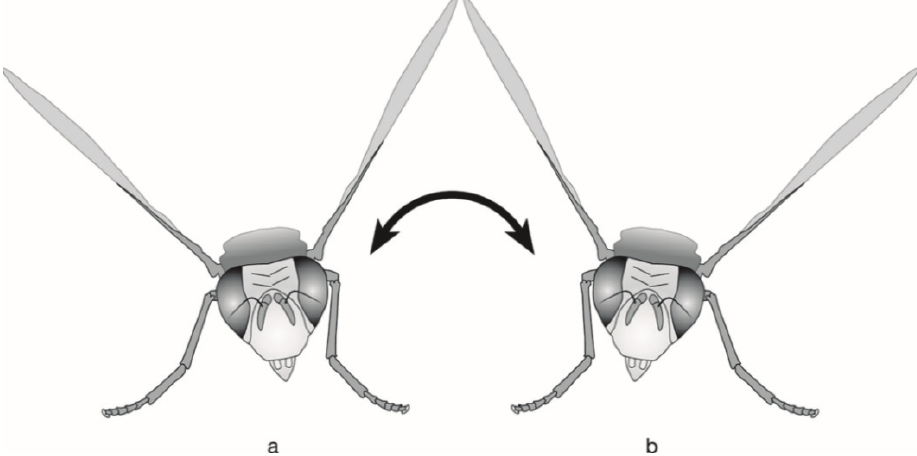
Figure 7. Illustration of the lofting/body swaying behavior of A. rufipes males. The wings are raised and arrested at an angle of about 45°, and the body is tilted alternately to the sides, while approaching the opponent (agonistic behavior) or mate (courtship